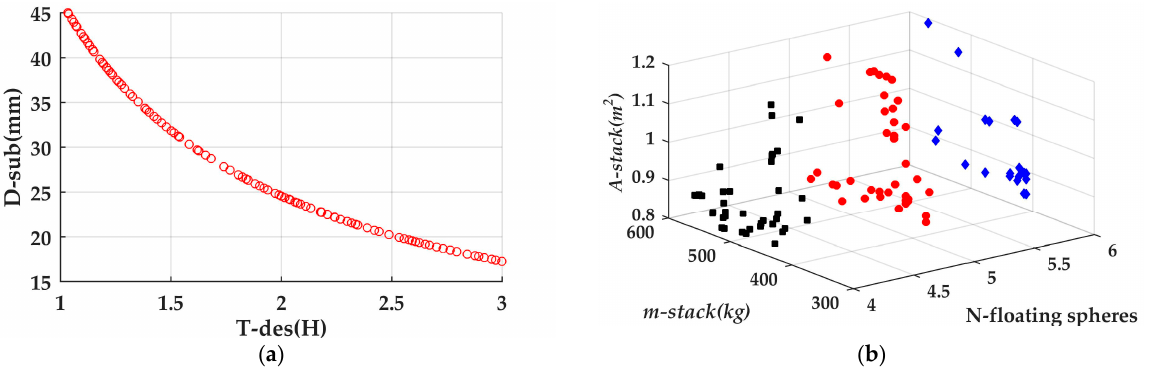
Figure 7. ( a ) The Pareto-optimal front of optimization results; ( b ) the distribution of the Pareto-optimal set. Table 5. Summary of optimization results.